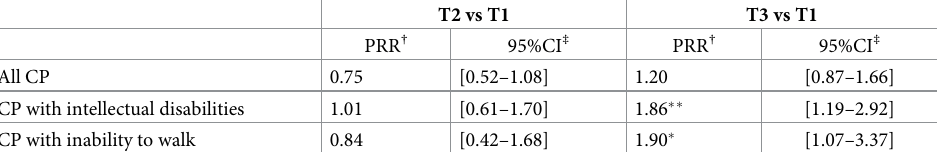
Table 1. Prevalence risk ratio (PRR) and 95% Confidence Interval (negative binomial regression models) by dep- rivation risk group defined by distribution tertiles of the French EDI γ weighted on the number of 8-year-old chil- dren residing in each block. The first tertile (T1) is the least deprived and the 3 rd tertile is the most deprived (T1 used as reference). Birth years 2000 to